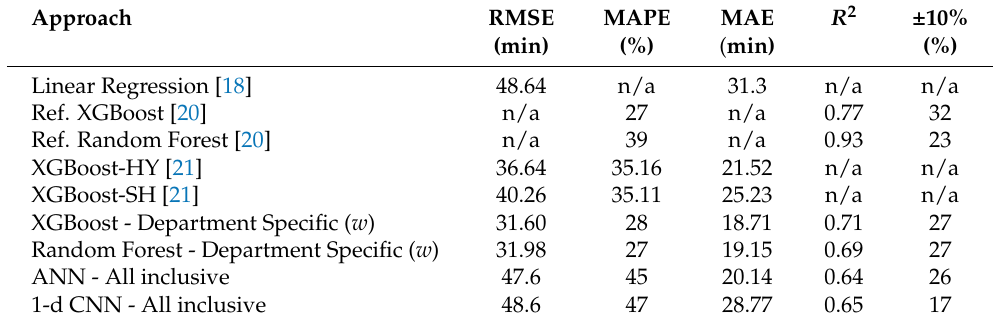
Table 4. Comparison with previous